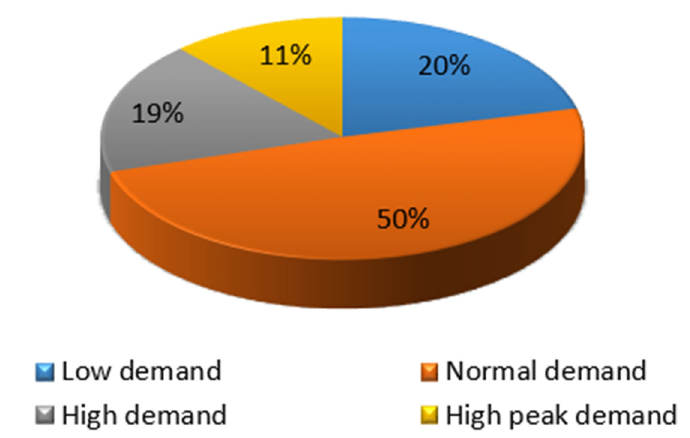
Figure 9. Distribution and classification of hourly household demand.